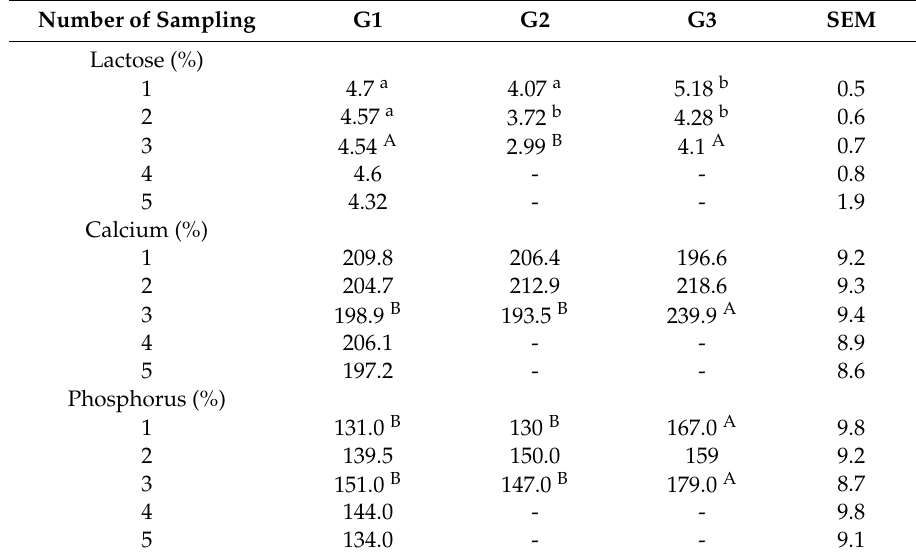
Table 5. Changes in lactose (%), calcium (%), and phosphorus (%) content in sheep’s milk from the Group 1 (lambing in February–milked from April to August, Group 2 (lambing in June–milked from August to October), Group 3 (lambing in June–milked from August to November and melatonin-treated before 6 weeks